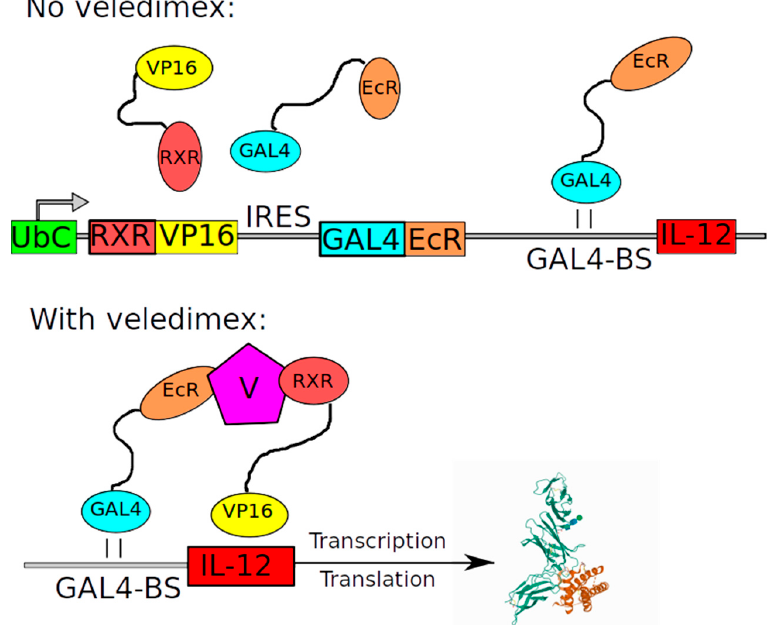
Figure 3. Schematic representation of RTS gene switch cassettes. Upon administration of veledimex, RXR-VP16 and GAL4-EcR proteins dimerize and activate transgene expression. The GAL4 domain recognizes unique specific binding sites (GAL4-BS) while VP16 acts as a powerful activation of transcription in mammalian cells. The protein 3D structure was adopted from Yoon et al. [37].